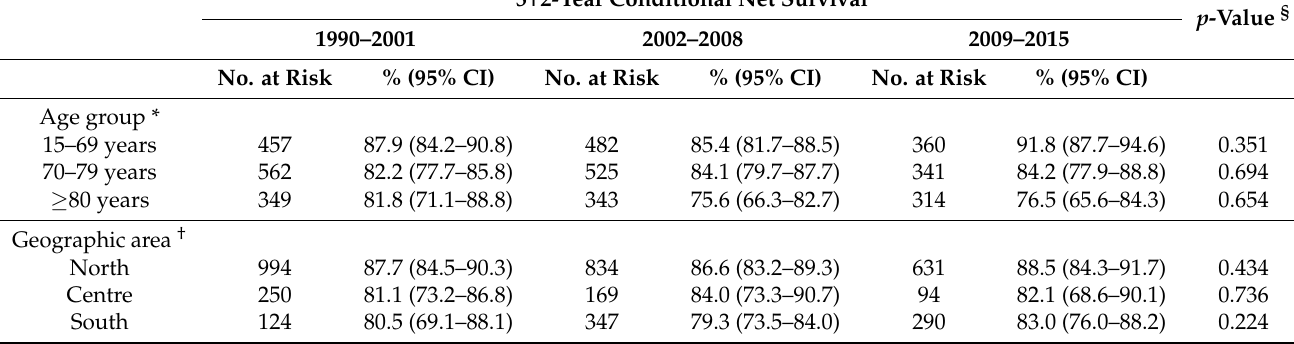
Table 5. Trend in 5|2-year conditional net survival from vulvar squamous cell carcinoma by age group at diagnosis and geographic area. Italy, 1990–2015 (total resident female population 15,358,161 in